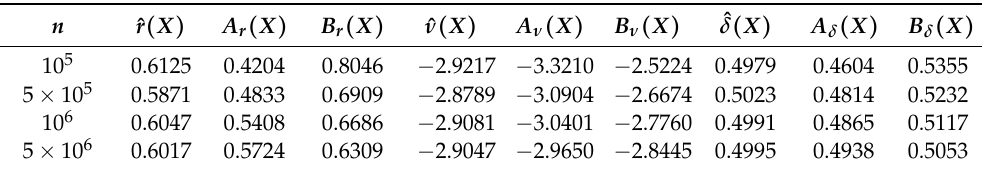
Table 8. Examples of estimates for the parameters and boundaries of confidence intervals for a